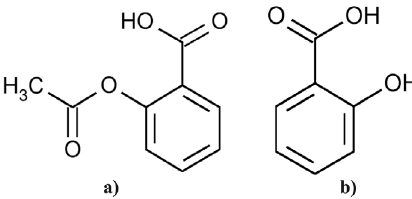
FIGURE 1 - Structural representations of acetylsalicylic acid (1a) and salicylic acid